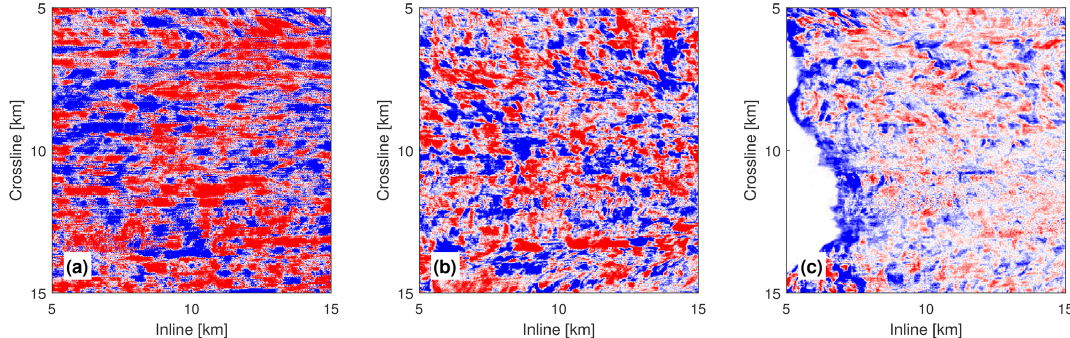
Figure 7. Seismic depth-slice images at three depths: (a) 250m, (b) 500m, and (c) 750m. The two axes show the lateral distance in the inline and crossline directions,